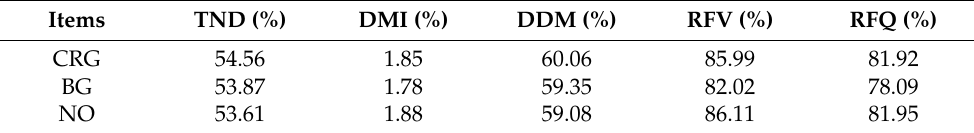
Table 8. Estimated feeding value of three forages (CRG, BG, and